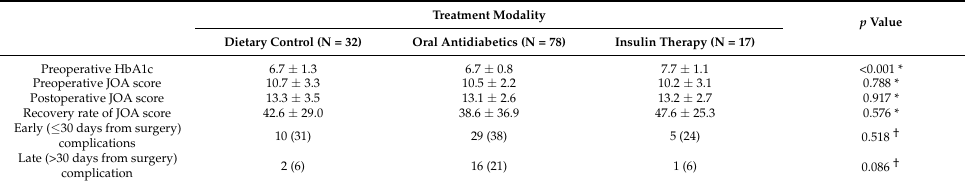
Table 6. Comparisons of surgical outcomes stratified by treatment modalities for diabetes